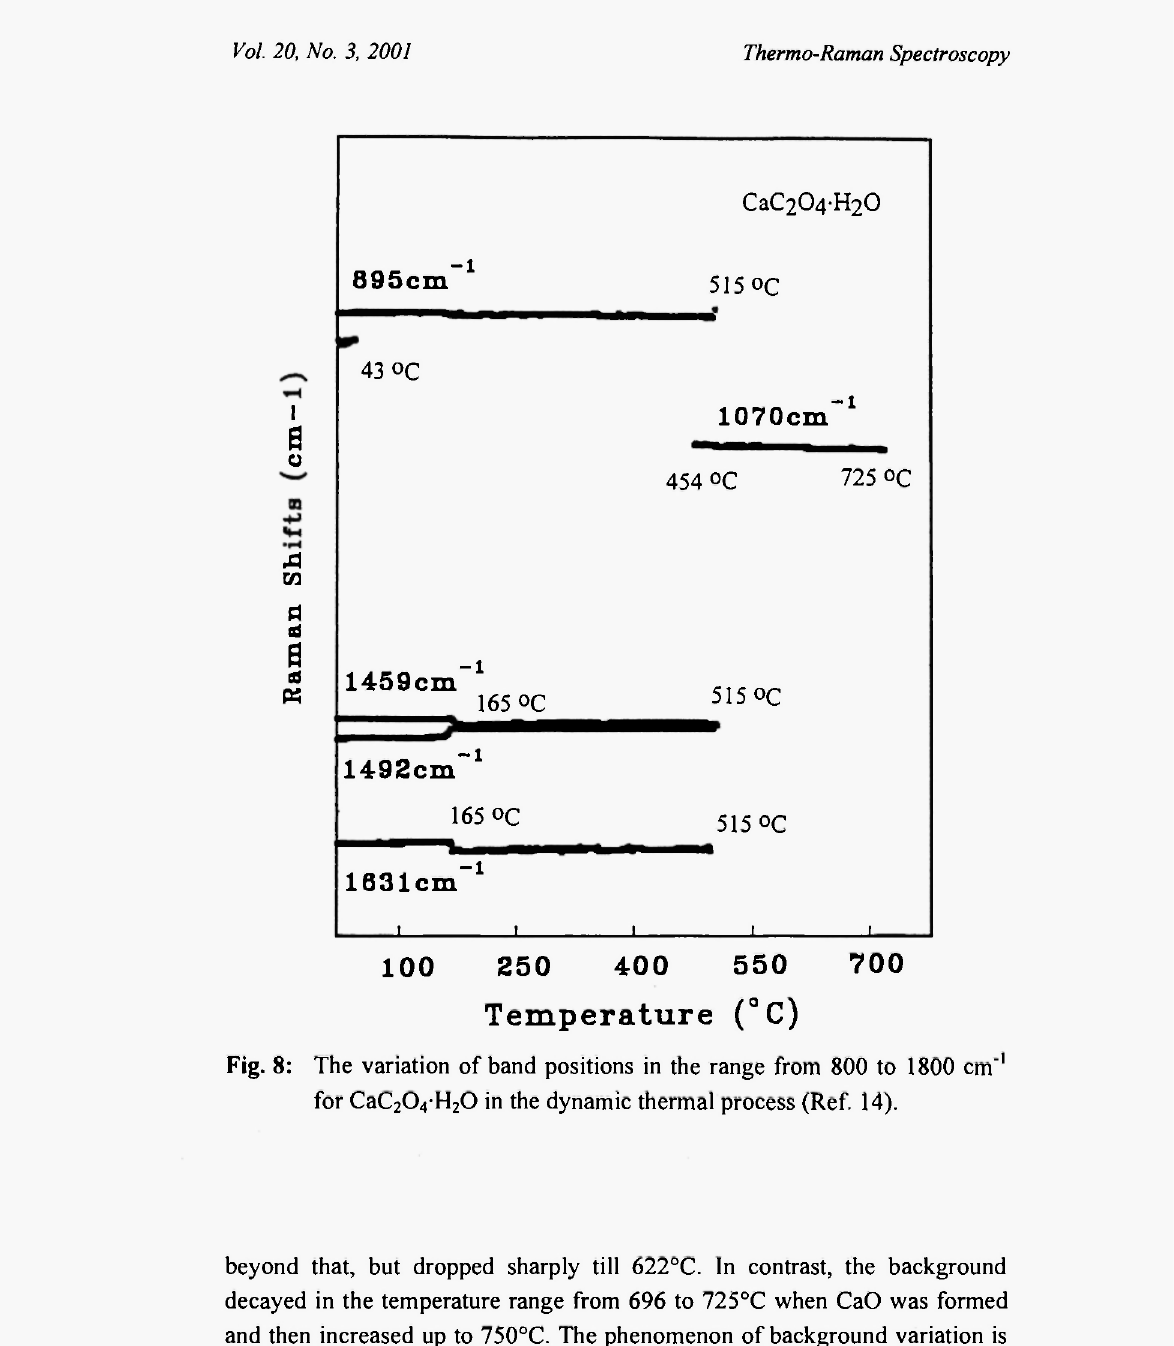
beyond that, but dropped sharply till 622°C. In contrast, the background decayed in the temperature range from 696 to 725°C when CaO was formed and then increased up to 750°C. The phenomenon of background variation is yet to be understood as regards its relevance during the thermal process. This may throw some light on the molecular rearrangement in the solid caused by the reaction when the old species changed to the new